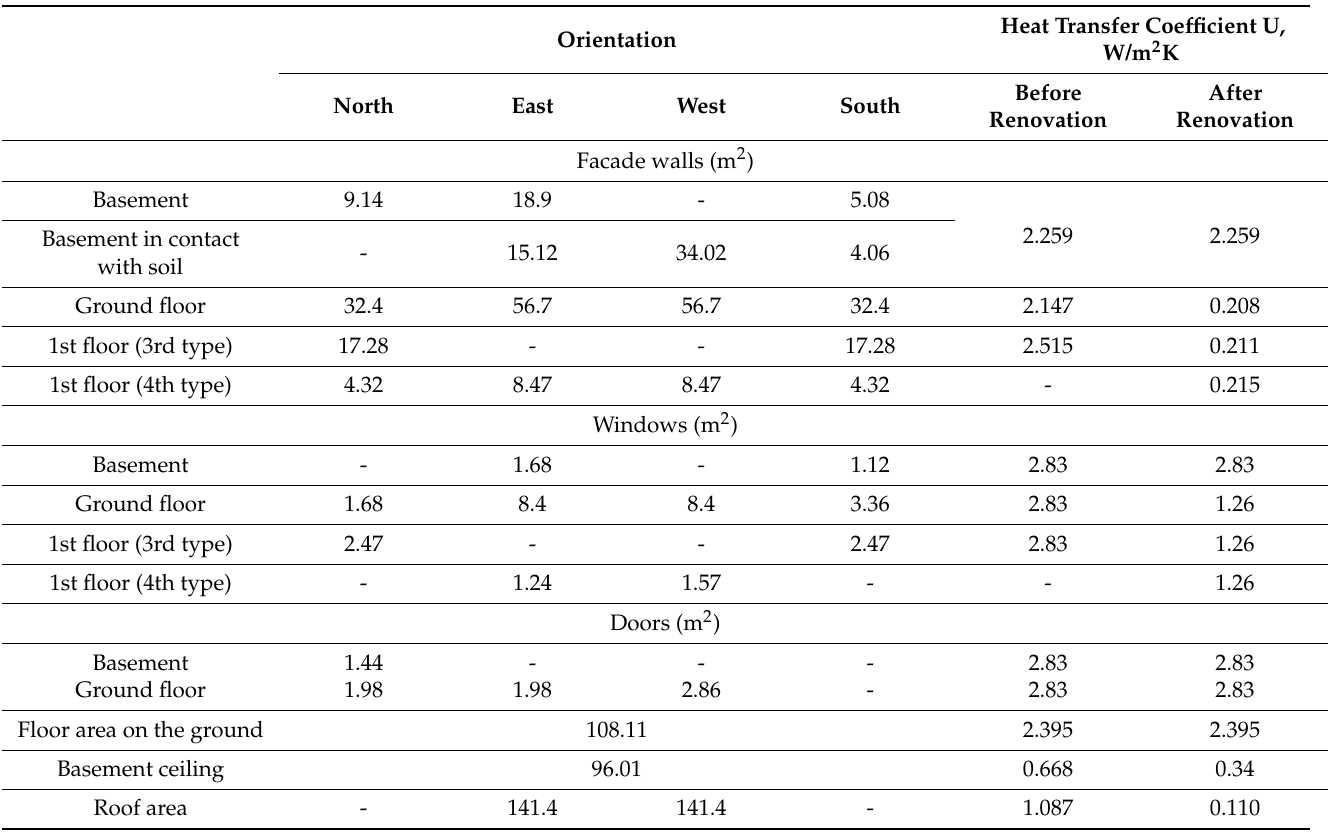
Table 6. Main input data about the case study